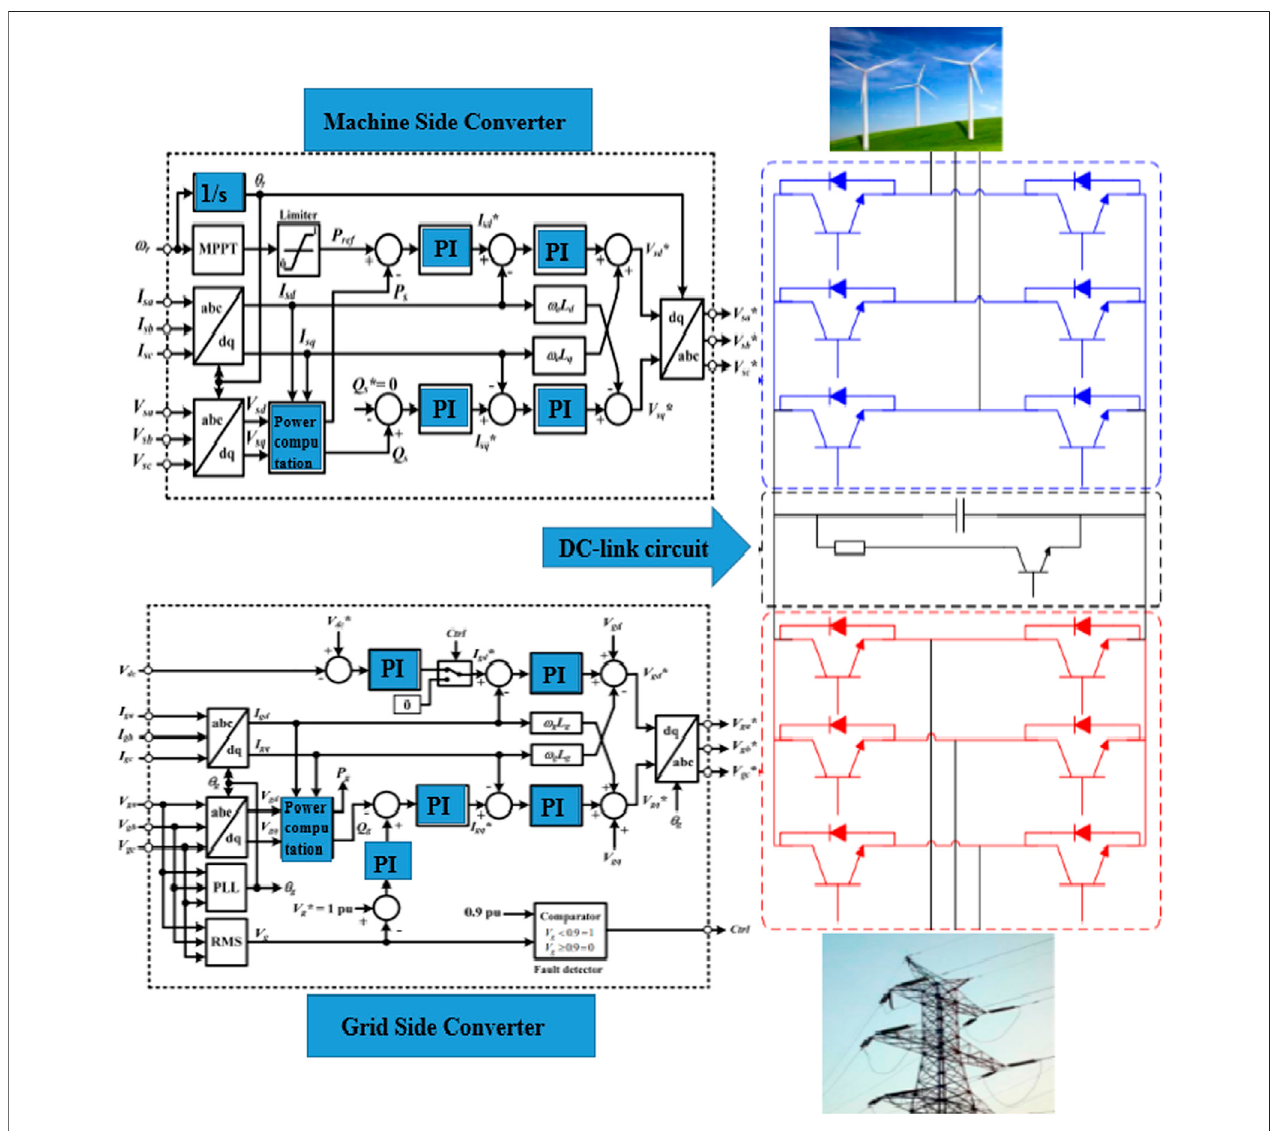
FIGURE 8 | Control strategy of the PMSG wind